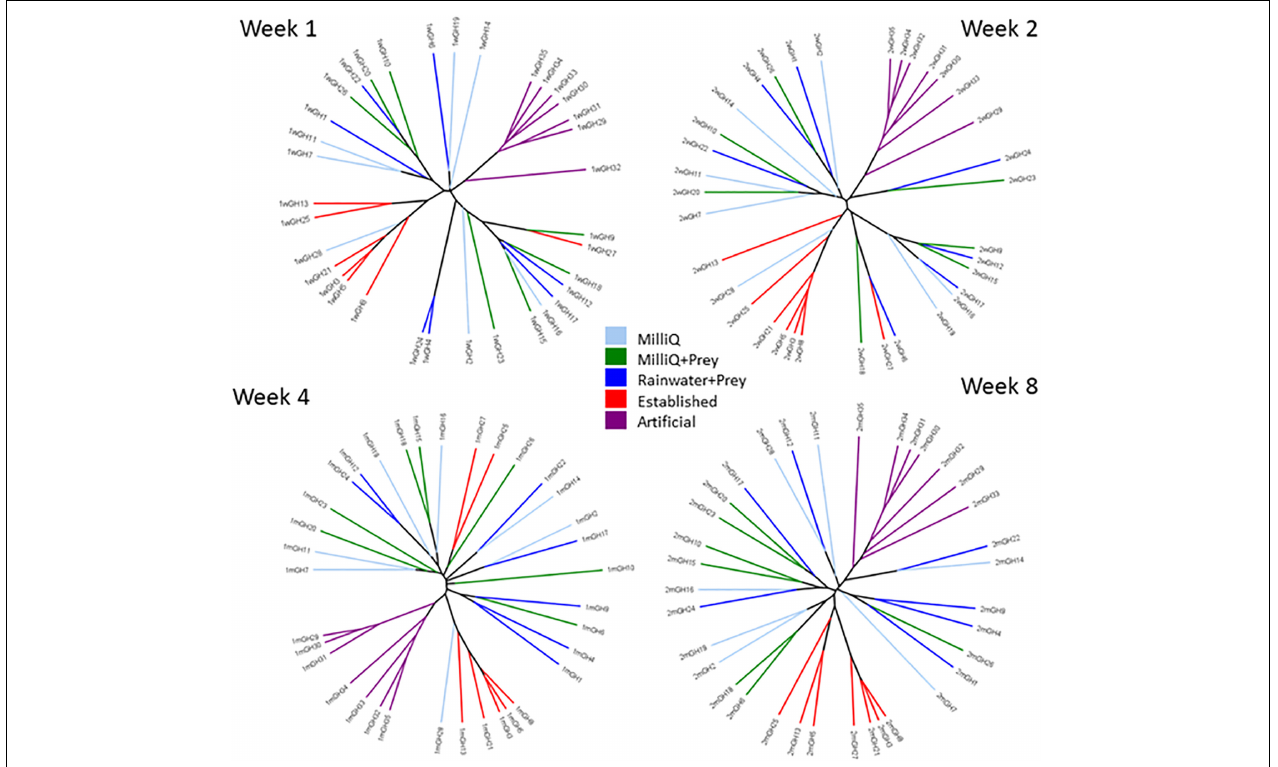
FIGURE 4 | Sample relatedness Newick formatted UPGMA trees created using the Bray-Curtis index from composition of OTUs in all seven replicate pitchers at 4 time points—1, 2, 4, and 8 weeks. Branches are color-coded by treatment (treatment abbreviations the same as Figure 1 ). Individual pitchers across the 5 treatments are labeled as